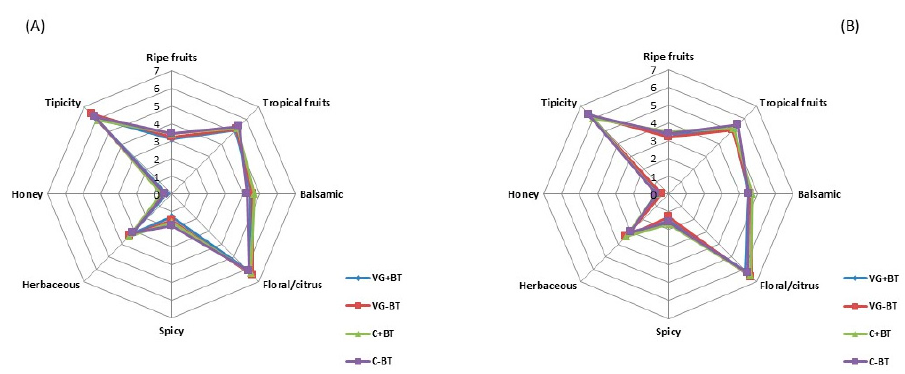
Figure 7. Odour profiles of the Falanghina experimental wines obtained in 2013 ( A ) and 2014 ( B